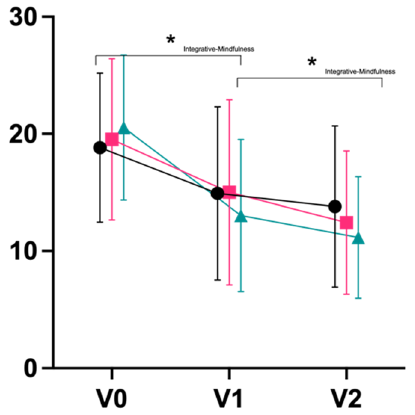
Figure 4. Exhaustion MBI (Mean ± SD). * = p < 0.05.